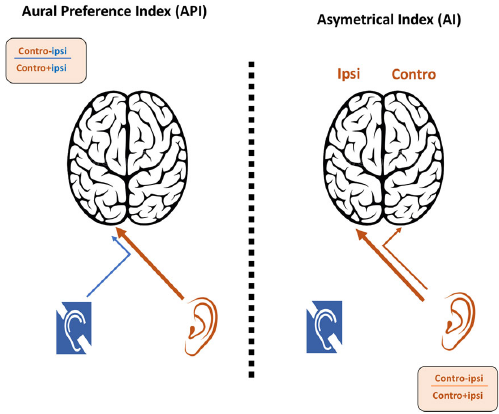
Figure 5. Illustration of the asymmetry index and aural preference index.